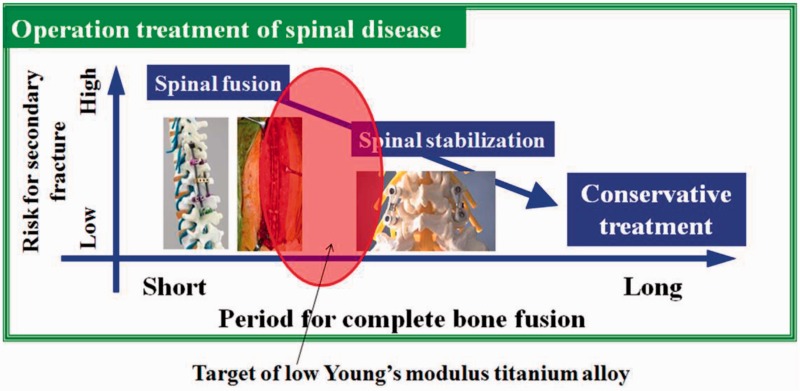
Schematic drawing of risk for secondary fracture and period for complete bone fusion in operation treatment of spinal disease.